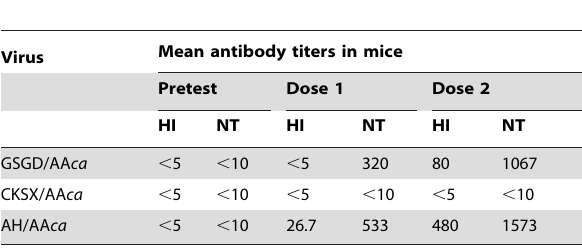
Table 3. Antibody response induced by the H5N1 ca reassortant viruses in